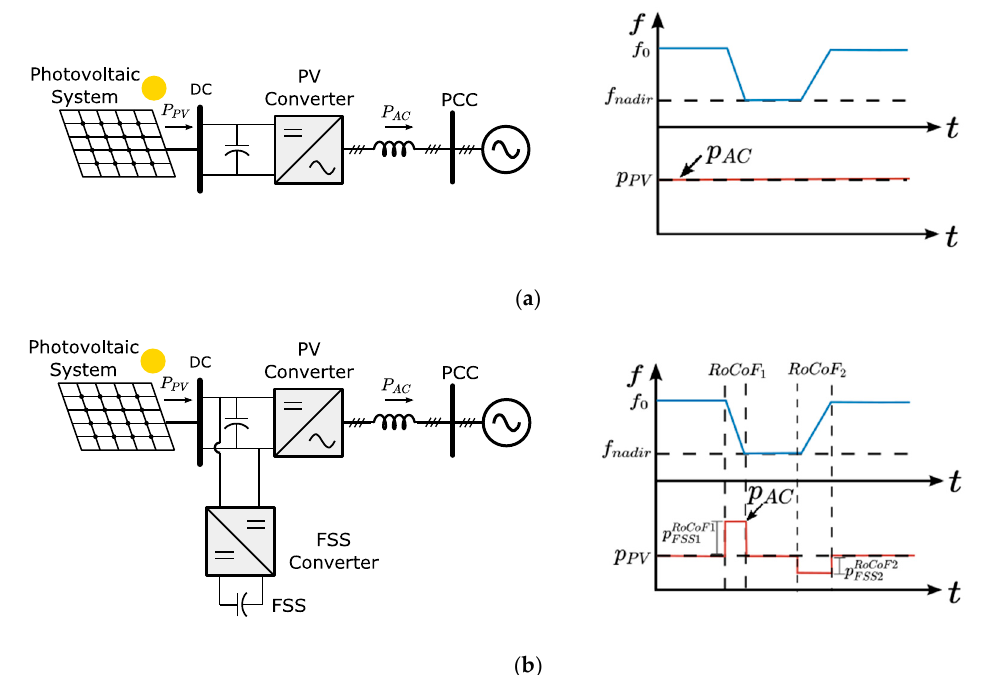
Figure 2. Illustrative example of a photovoltaic (PV) plant ( a ) conventionally, without storage at the DC-link and the DC/AC inverter controlled as current source, no inertial response can be exhibited, ( b ) equipped with a Fast Storage System (FSS) at DC-link, where the DC/AC inverter is controlled as voltage source. In case ( b ) inertial response can be provided.